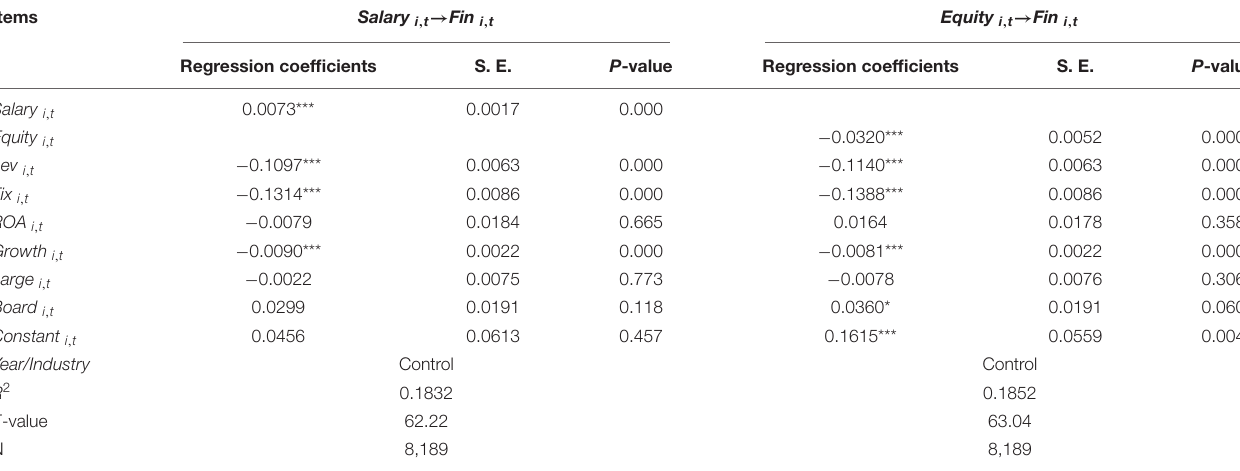
TABLE 9 | Managers’ incentive and corporate financialization.